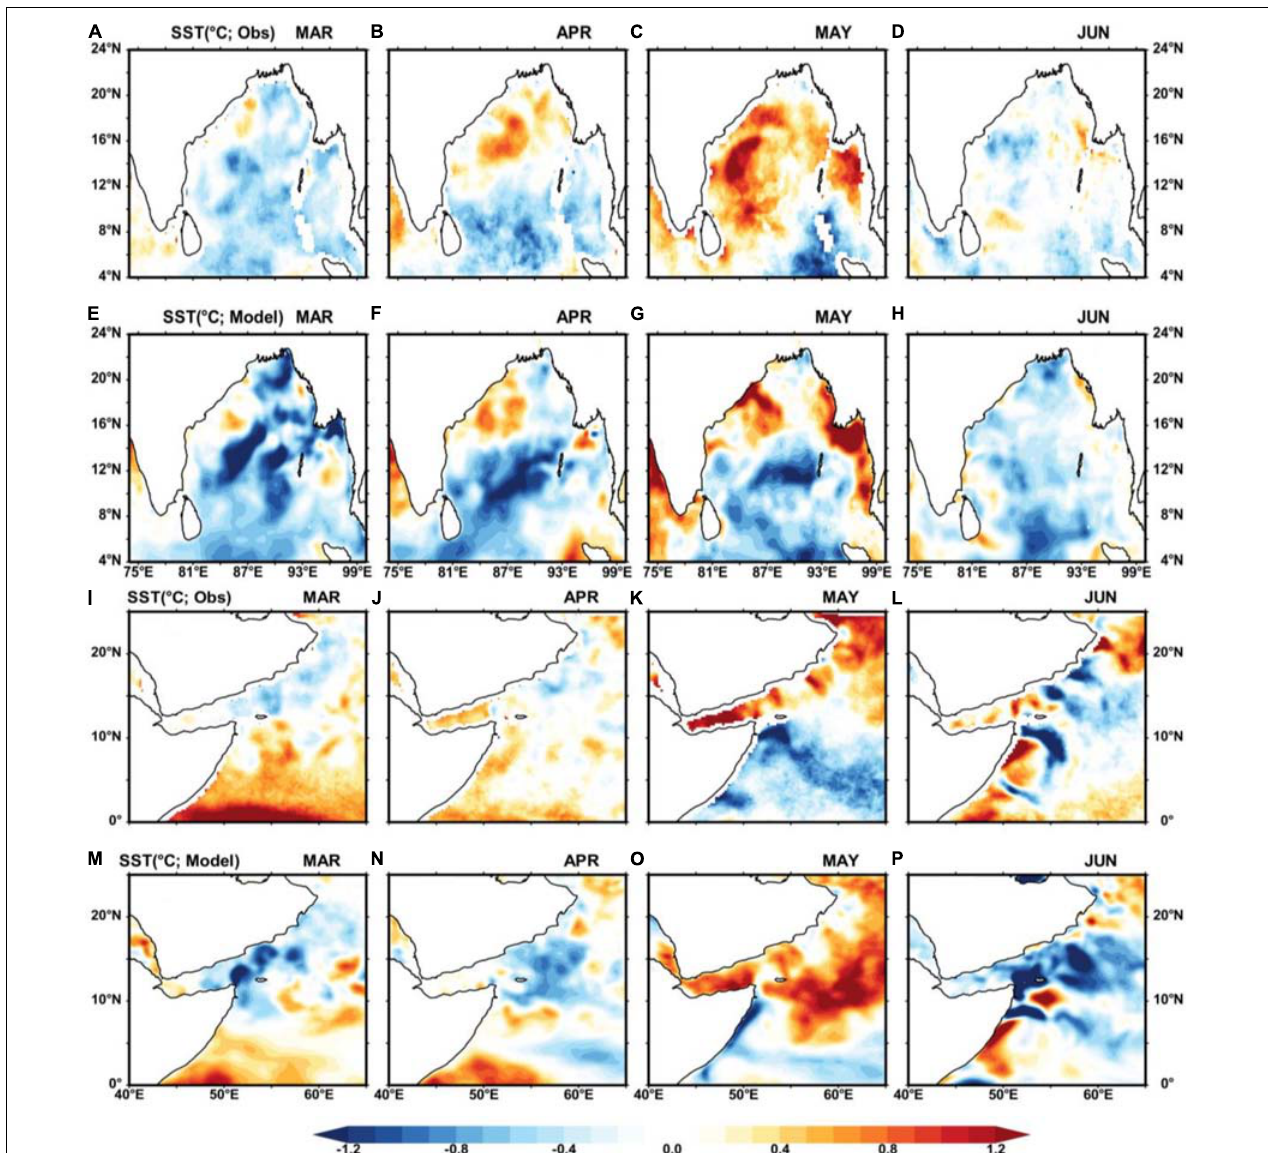
FIGURE 3 | Sea surface temperature (SST) difference (degree centigrade) from pandemic period (March–June of 2020) to pre-pandemic period (March–June of 2019) from the observations (rows 1 and 3) and model simulations (rows 2 and 4) over the BoB (rows 1 and 2) and WAS (rows 3 and